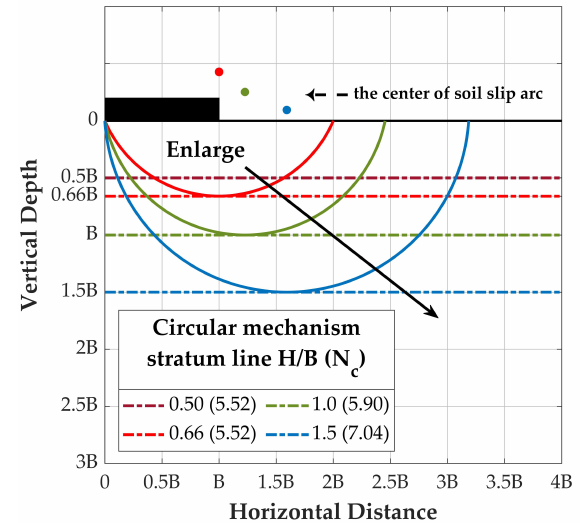
Figure 11. Slip surfaces enlarge with the increasing H / B for a thick upper